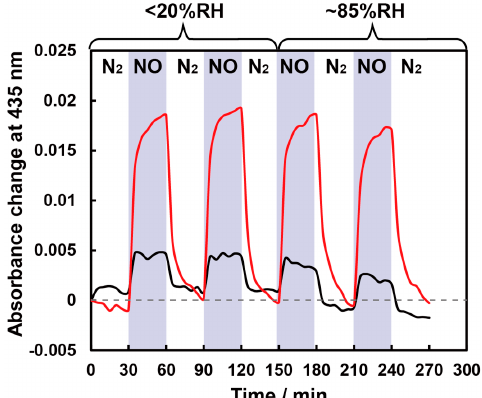
Figure 5. One ppm NO sensing at 100 °C under low humidity (<20 RH%) and high humidity (85 RH%) conditions for CoTPP-EC film (red solid line) and CoTPP film (black solid line). The blue zone indicates the period of NO gas introduction.